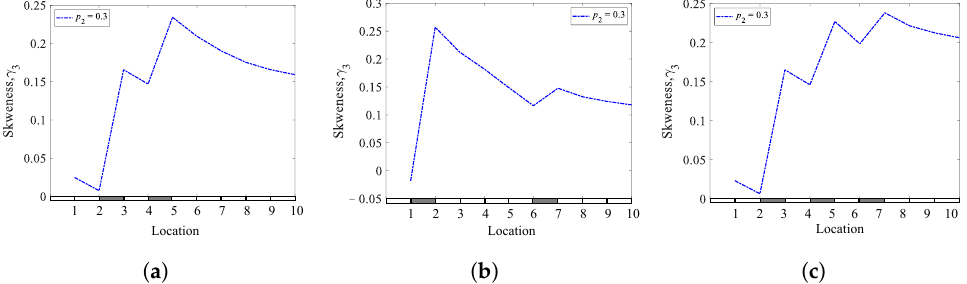
Figure 32. Skewness coefficients of a cantilever beam with multiple cracks for different crack depths and locations: ( a ) q = 0.25 and 0.45; ( b ) q = 0.15 and 0.65; ( c ) q = 0.25, 0.45, and 0.65.